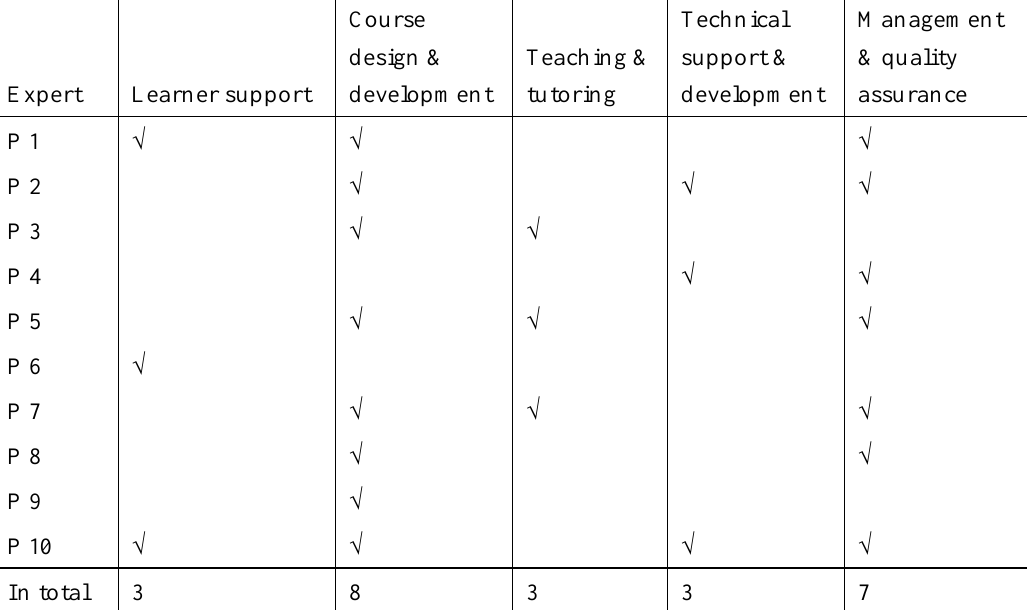
Table 2 Experts’ Role Backgrounds Expert Learner support